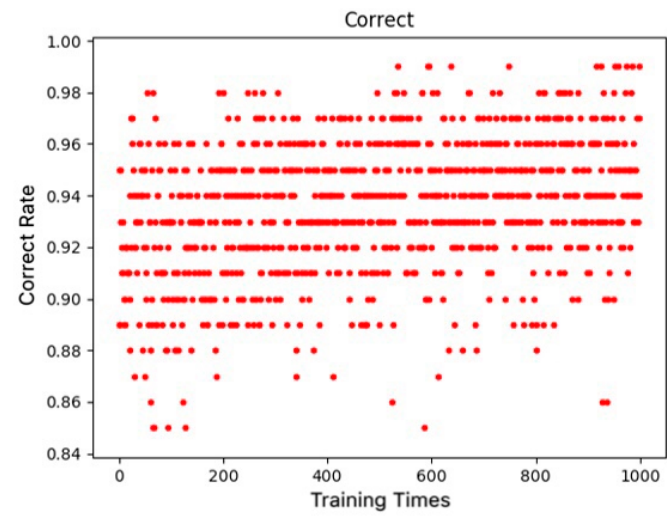
Figure 10. Correct rates of transformation training.